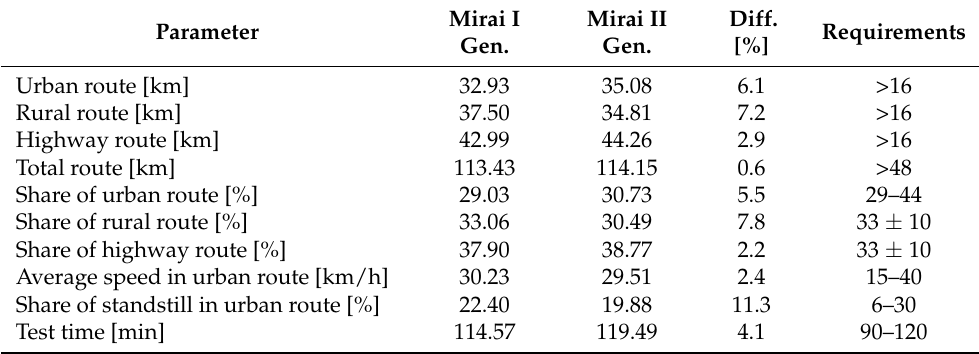
Table 2. Selected conditions required for a valid RDC test.